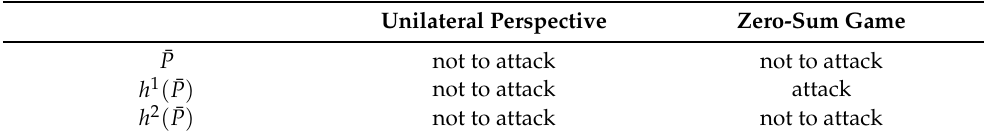
Table 9. The optimal polices of attacker under different